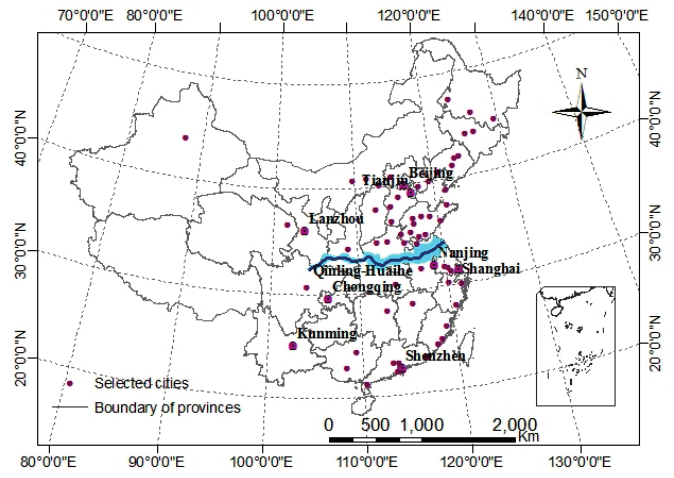
Figure 1. Sixty-seven selected cities in this research. The eight labeled cities are typical cities discussed in the